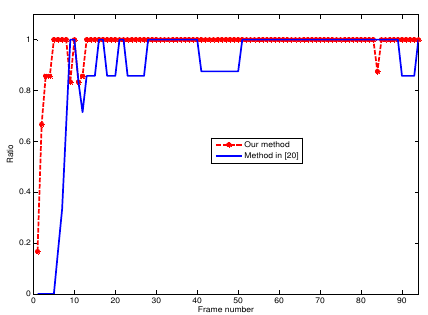
Fig. 9. The ratio between the number of objects detected accurately and the number of reality